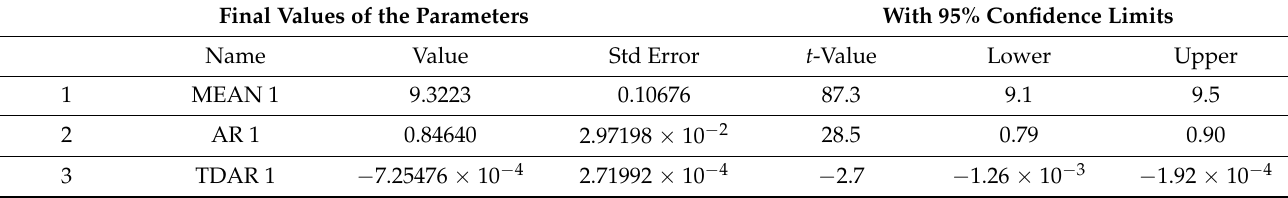
Table 1. Estimates of a (homoscedastic) tdAR(1) model defined by (1) for p = 1 with a constant (denoted MEAN 1). The parameters φ (cid:48) and φ (cid:48)(cid:48) are, respectively, denoted as AR 1 and TDAR 1. 1 1 Final Values of the Parameters With 95% Confidence